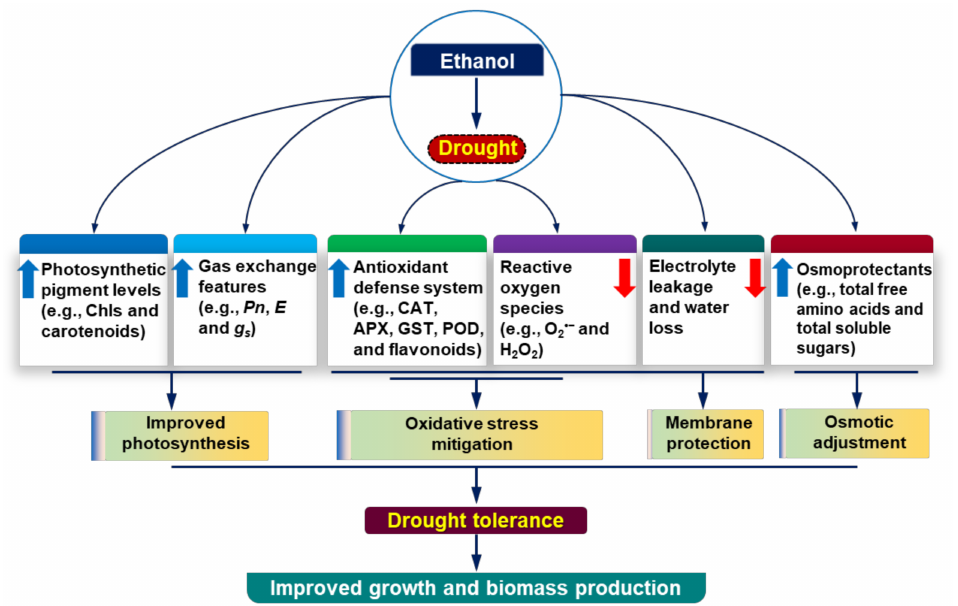
Figure 7. The regulatory roles of ethanol in alleviating drought-induced adverse effects in soybean plants. Foliar application of exogenous ethanol to drought-stressed soybean plants considerably rescued growth phenotypes, partly through the protection of photosynthetic pigments and improve- ment of gas exchange parameters, which ultimately increased the overall photosynthetic rate to improve growth performance. Exogenous ethanol also triggered the action of the antioxidant defense system by enhancing the activities of enzymatic antioxidants (e.g., CAT, APX, GST, and POD) and the levels of non-enzymatic antioxidants (e.g., total flavonoids), which together contributed to the protection of soybean plants from reactive oxygen species-induced oxidative stress and membrane damage. Additionally, the external application of ethanol enhanced the levels of osmoprotectants (e.g., free amino acids and soluble sugars) to maintain leaf water status for osmotic adjustment under drought circumstances. Upward (blue) and downward (red) arrows indicate increase and decrease, respectively. APX, ascorbate peroxidase; CAT, catalase; Chls, Chlorophylls; E , transpiration rate; GST, glutathione S -transferase; g s , stomatal conductance to H 2 O; H 2 O 2 , hydrogen peroxide; O 2 •− , superoxide; POD, peroxidase; Pn , net photosynthetic